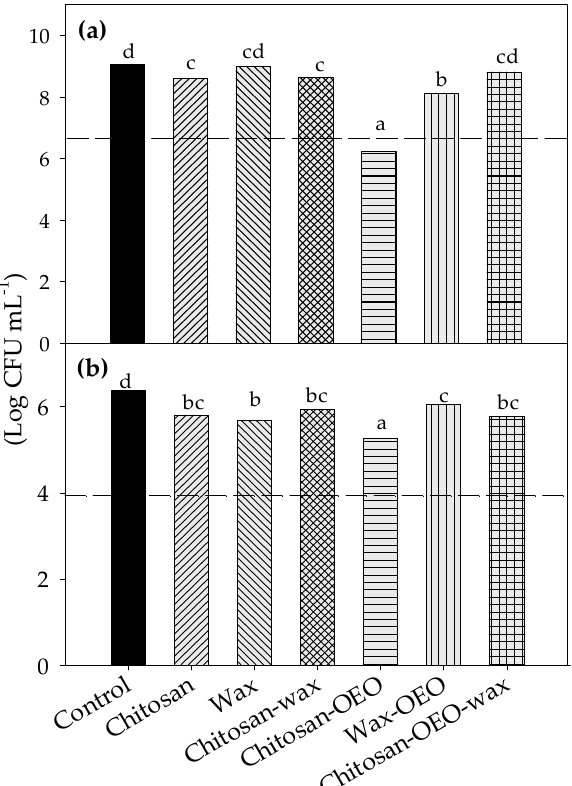
Figure 3. Antimicrobial activity of chitosan, carnauba wax, and oregano essential oil (OEO) films against mesophilic bacteria ( a ) and fungi ( b ) isolated from the decayed cucumber. Dotted lines signify the added inocula, and different letters among bars indicate significant differences ( p ≤ 0.05).